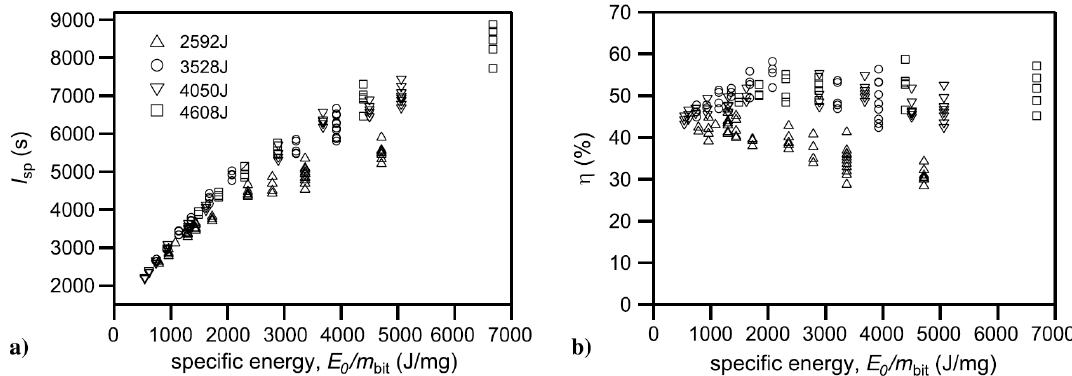
Figure 4. ( a ) Specific impulse and ( b ) thrust efficiency as a function of specific energy for the PIT MK Va thruster operating on ammonia propellant (data from